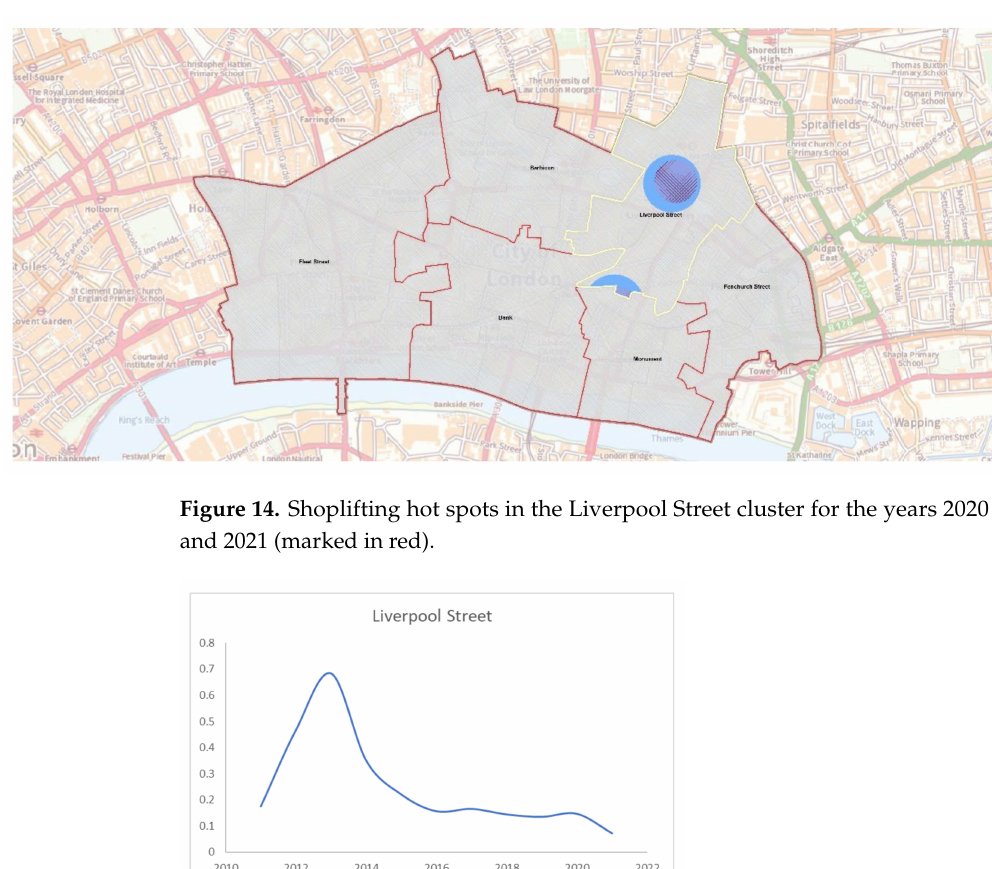
Figure 13. Shoplifting hot spots in the Liverpool Street cluster for the years 2019 (marked in blue) and 2020 (marked in red).